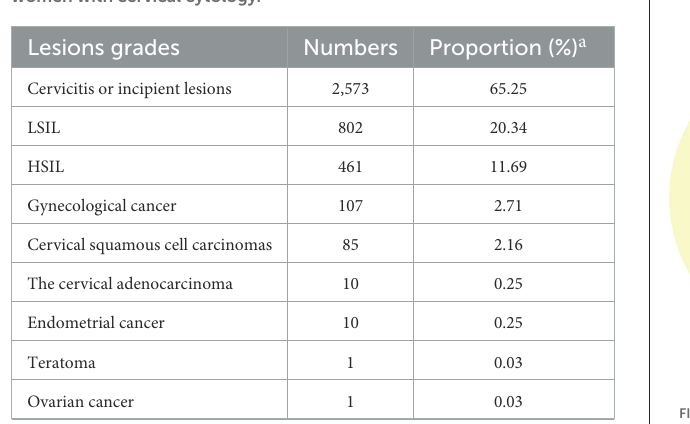
FIGURE5 The number of participants in each